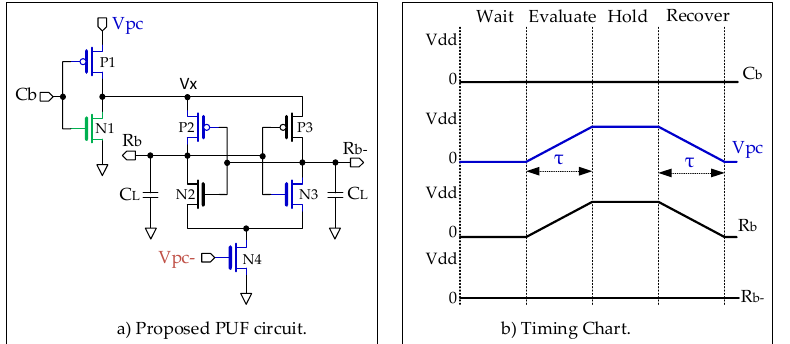
Figure 3. ( a ) Proposed Adiabatic PUF circuit and ( b ) its timing chart. The supply voltage Vpc swings between 0.9 and 1.8 V (peak to peak voltage is 0.9 V), while the Vpc- fluctuates between 0 and 0.9 V. The Vpc and Vpc- signals are set such that all output nodes are discharged back to Vpc and ground simultaneously to avoid floating